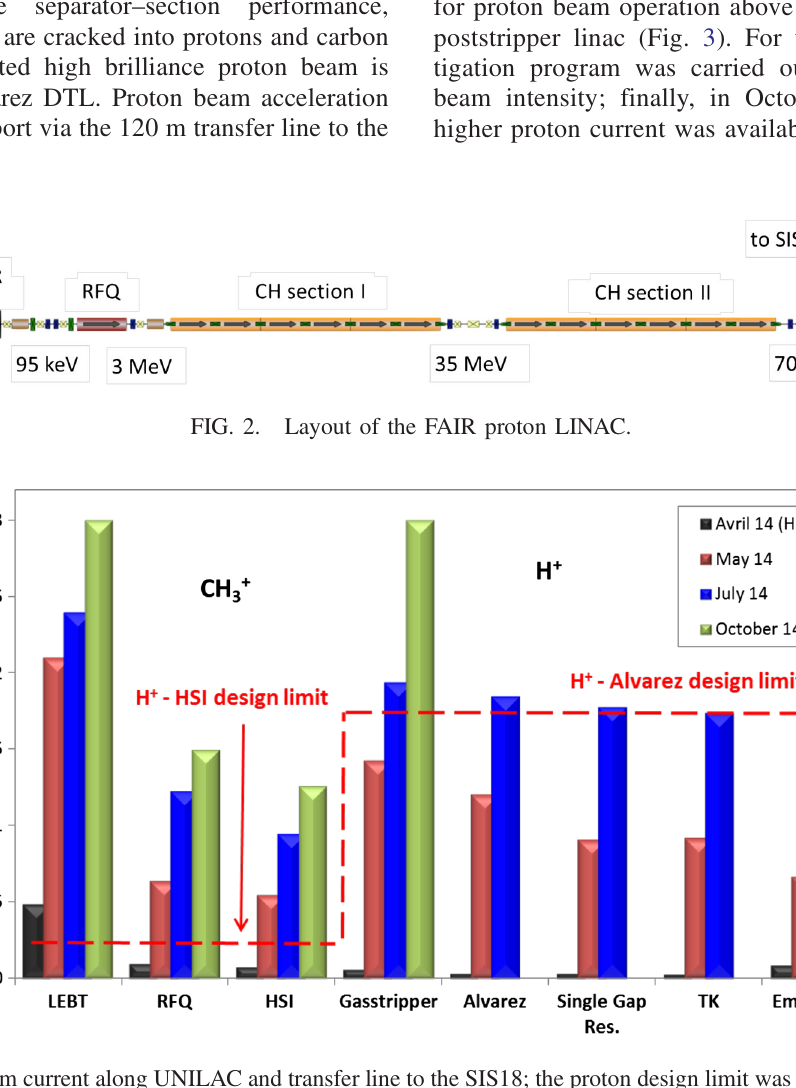
FIG. 3. Measured beam current along UNILAC and transfer line to the SIS18; the proton design limit was reached in the poststripper